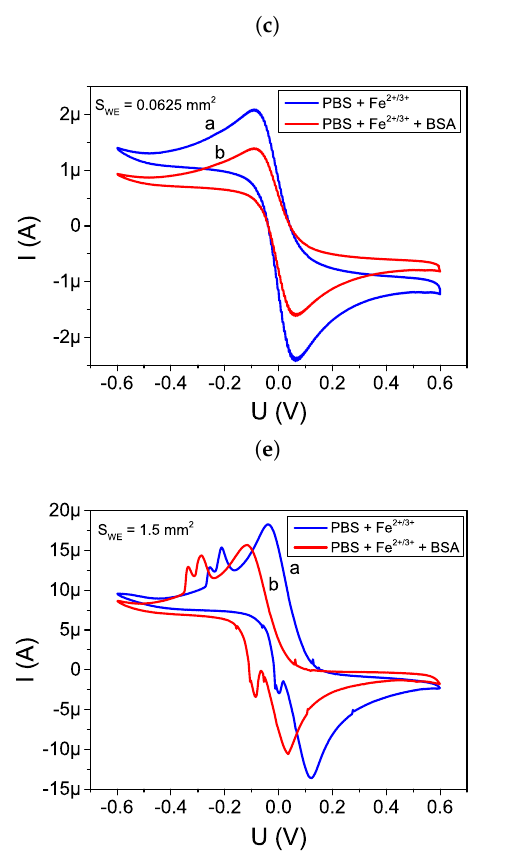
Figure 12. Cyclic voltammograms recorded in a 0.5 mM Fe 2 + /3 + + PBS solution after different step of modification, (a) bare Au WE, (b) BSA adsorption on WE electrode for sensors no ( a ) 5 ( S WE , CE = 1 mm 2 ), ( b ) 3 ( S WE , CE = 0.5 mm 2 ), ( c ) 1 ( S WE , CE = 0.0625 mm 2 ), ( d ) 6 ( S WE , CE = 1.25 mm 2 ) and ( e ) 7 ( S WE , CE = 1.5 mm 2 ).